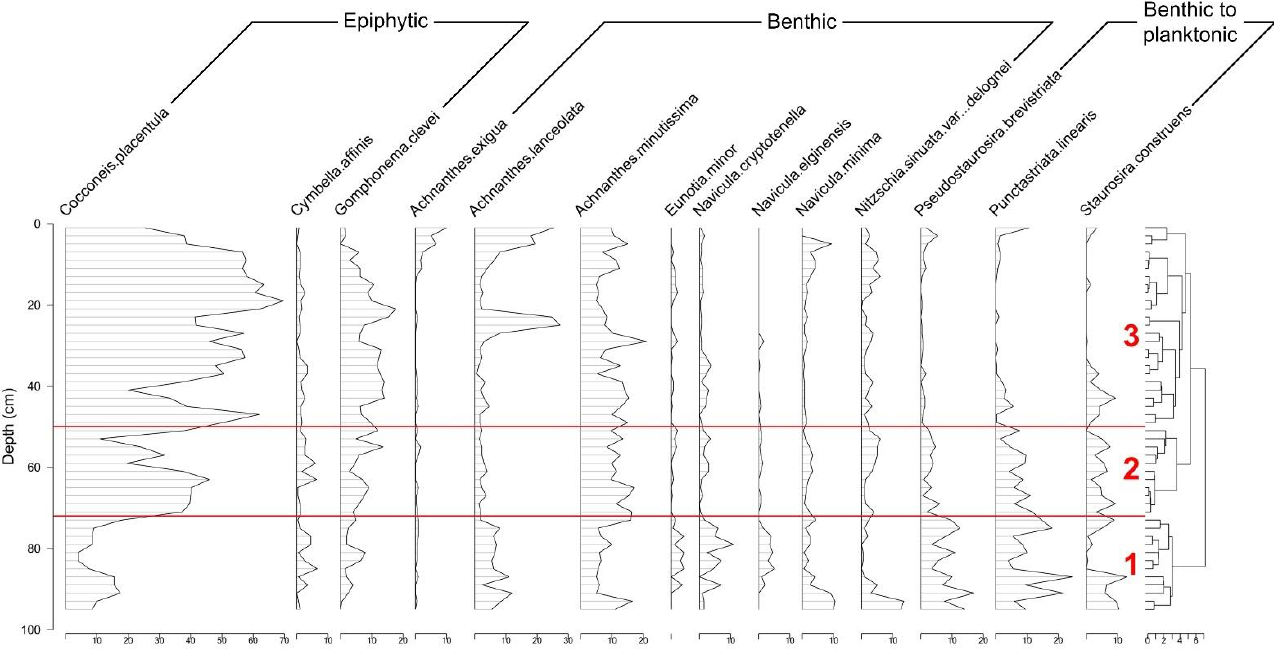
Figure 5. Profile of species richness (richness), species evenness (evenness), and β -diversity (β -sim, β -sen, and β -sor) in the three diatom zones. 1960 1965 1970 1975 1980 1985 1990 1995 2000 2005 2010